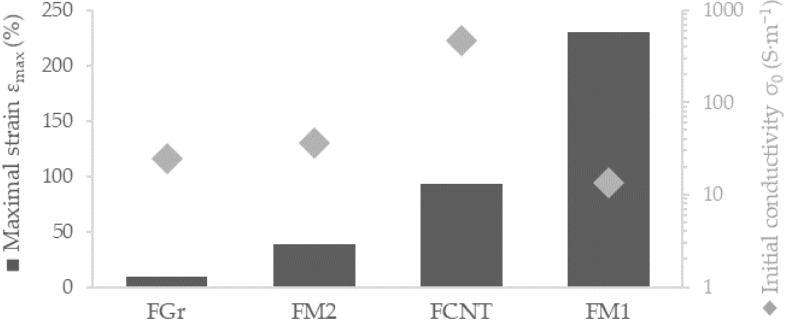
Figure 2. Breaking strain for different carbon/SBS composite 0.5 mm fibers with the assessment of the conductivity of the unstrained fiber. FGr is Gr/SBS filament; FCNT is CNT/SBS composition; and FM1 and FM2 are mixes of SBS, graphite, and CNT in different ratios.